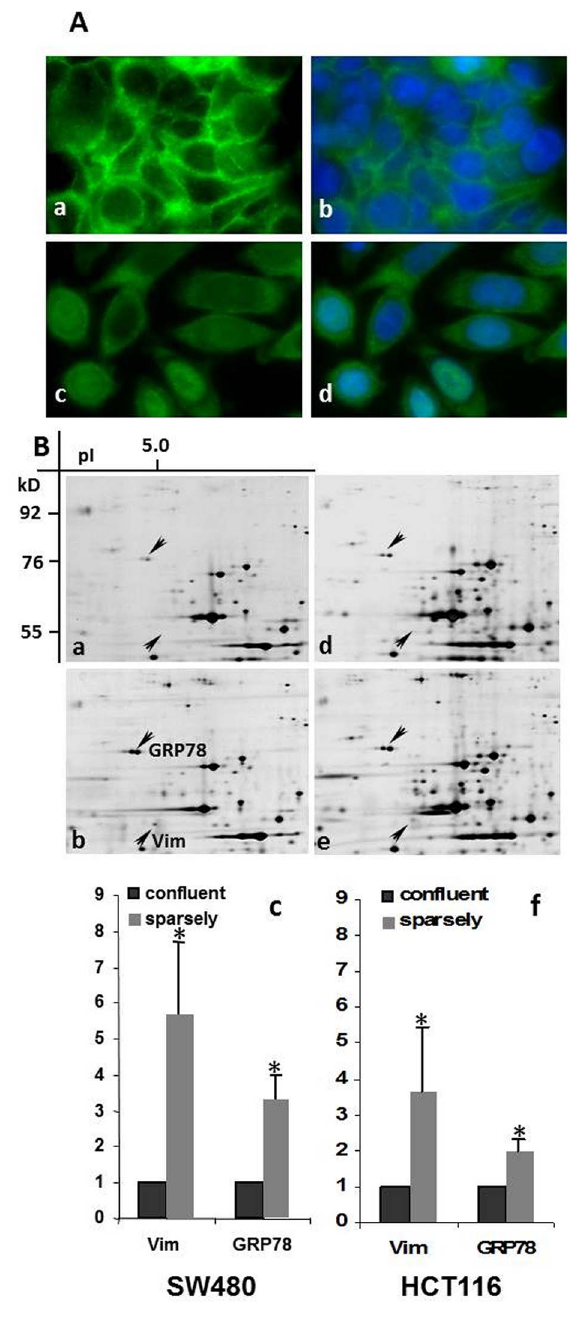
Figure 1. EMT is associated with an ER-stress response in CRC cell lines. A . Confluent growing SW480 cells are characterized by an epithelial growth pattern with membranous localization of b -catenin (a; green fluorescence). Sparsely growing cells, mimicking EMT display a mesenchymal growth pattern with cytoplasmic/nuclear localization of b -catenin (c; green fluorescence). Nuclei were counterstained by DAPI staining (b, d; blue fluorescence). (Magnification 630 6 ). B . Quantitative changes in protein amount of the EMT-associated proteins vimentin (Vim) (located in 2-DE gels at 55.0 kD/pI 5.1) (arrows) and GRP78 (76.0 kD/pI 5.0) are presented in selected 2-DE areas: a . confluent SW480 cells; b . sparsely growing SW480 cells; c . quantification of the amount (n-fold) of vimentin (Vim) and GRP78 in confluent and sparsely growing SW480 cells d . confluent HCT116 cells; e . sparsely growing HCT116 cells. f . quantification of the amount (n-fold) of vimentin (Vim) and GRP78 in confluent and sparsely growing HCT116 cells. Data